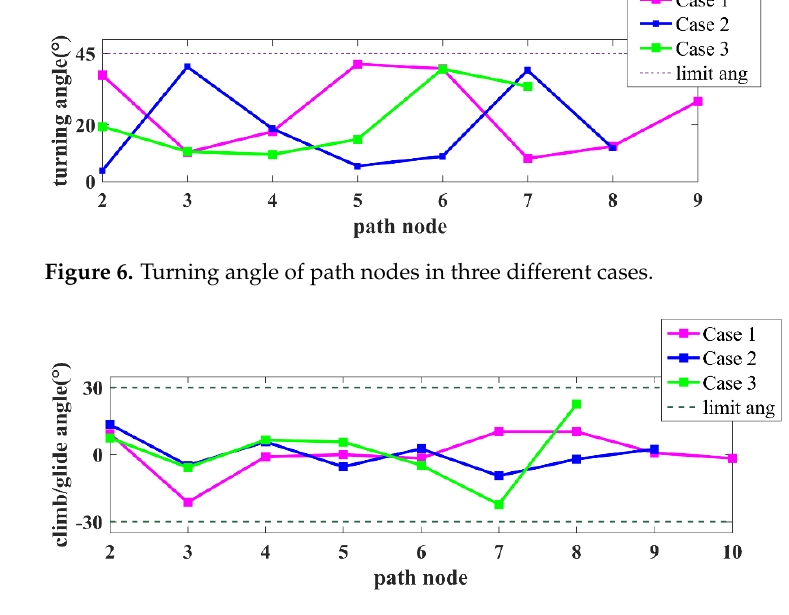
Figure 7. Climbing/gliding angle of path nodes in three different cases.